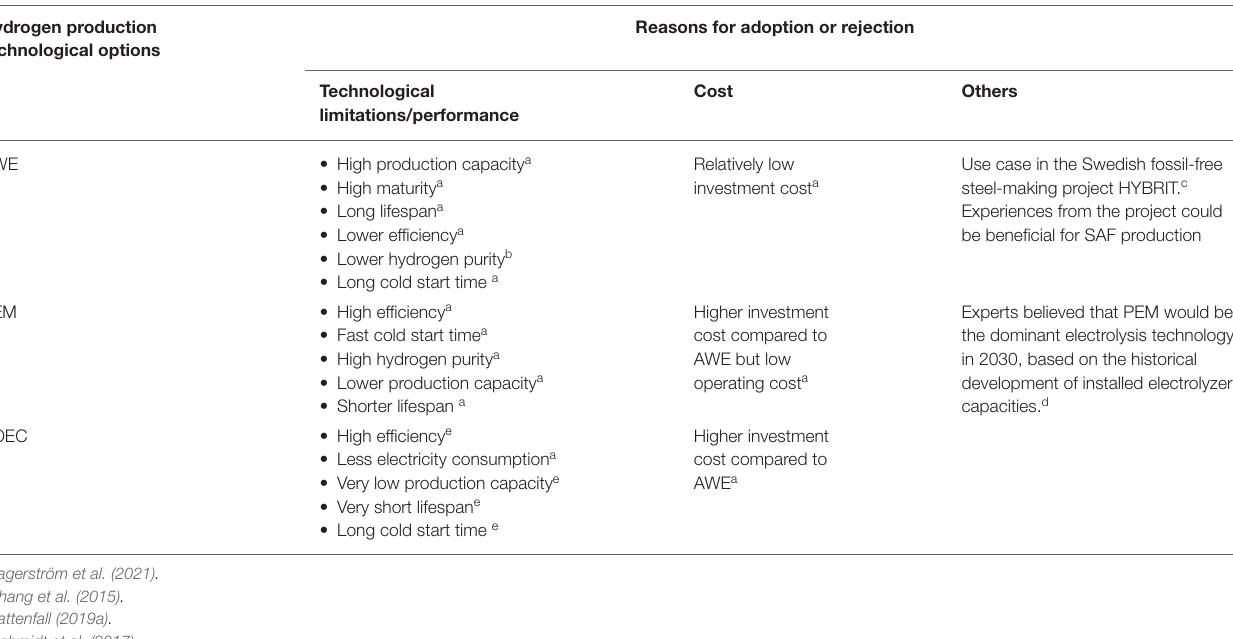
TABLE 1 | Technological limitations/performance, cost, and development of other sectors that affect the selection of hydrogen production technology.